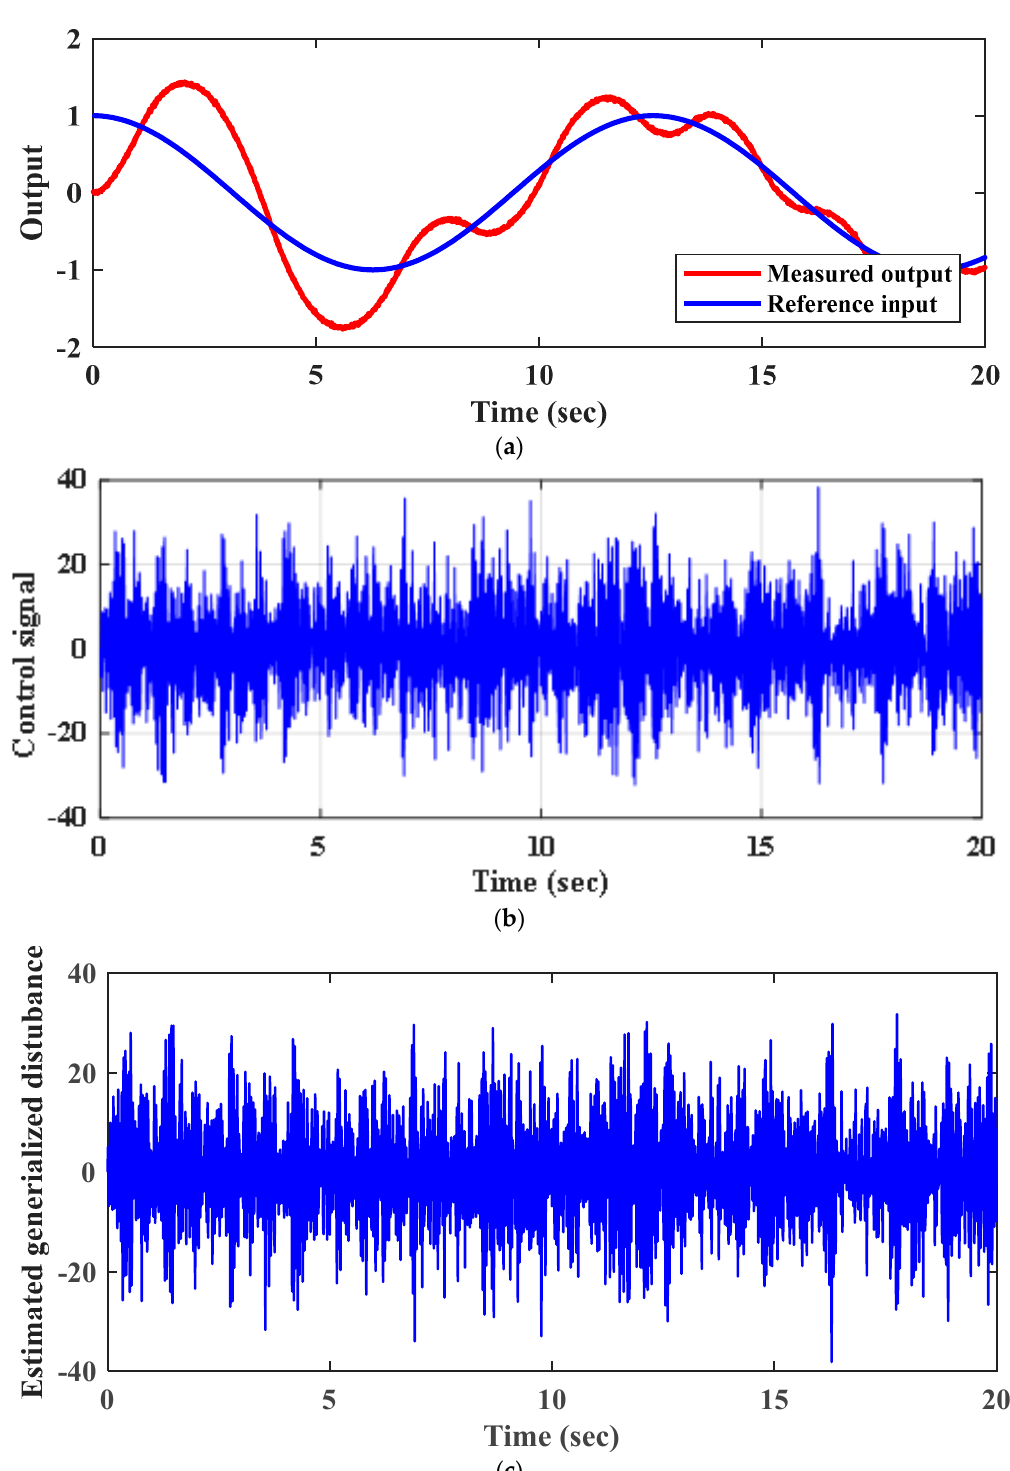
Figure 3. Results of the numerical simulation for Scenario 1: ( a ) tracking response y of the reference input r ; ( b ) control action u ; ( c ) estimation of the generalized disturbance ˆ ξ 3